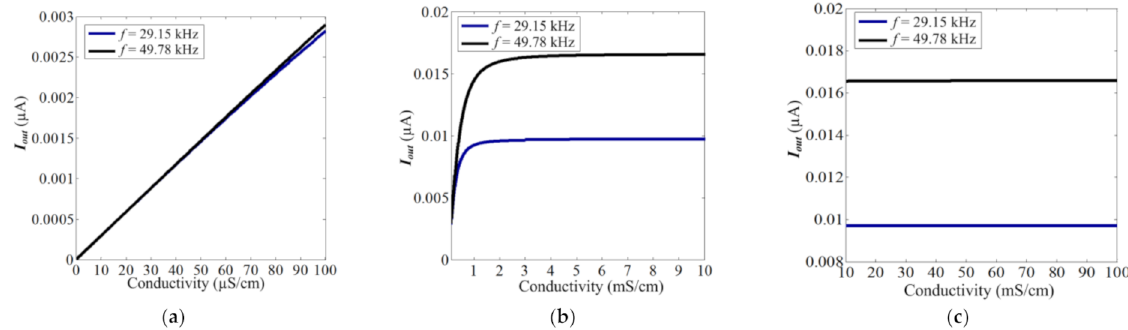
Figure 10. The theoretical curves of Equation (7) (the C 4 D sensor without the LC circuit). ( a ) The detailed theoretical curves of Equation (7) under the conductivity range of 1–100 µ S/cm. ( b ) The detailed theoretical curves of Equation (7) under the conductivity range of 100 µ S/cm–10 mS/cm. ( c ) The detailed theoretical curves of Equation (7) under the conductivity range of 10–100